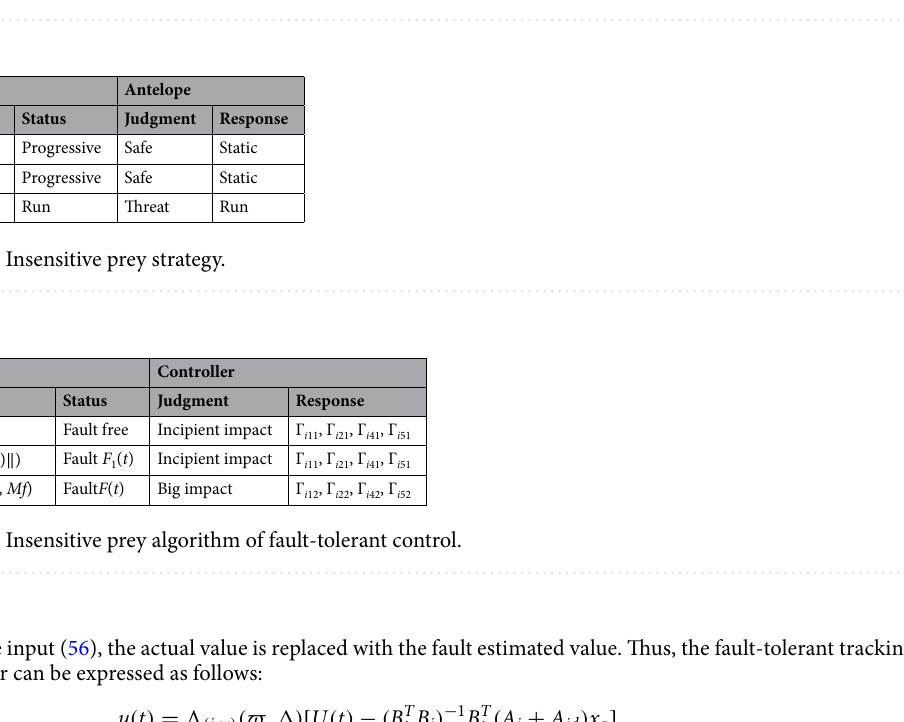
Figure 4 is a decision tree showing the architecture of the prey algorithm. The algorithm steps are as follows: Step 1 Fault amplitude is less than or equal to κ , no fault, parameters are set to Γ i 11 /Γ i 21 /Γ i 41 /Γ i 51 .